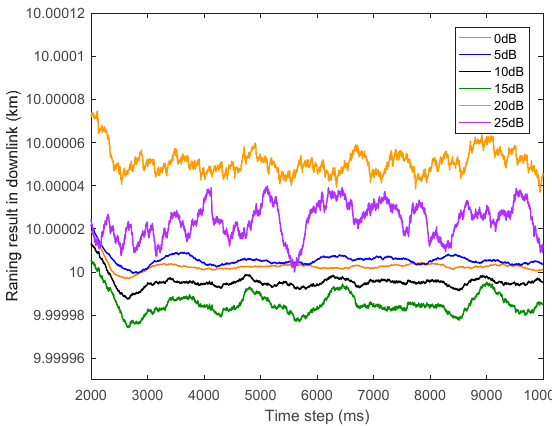
ff erent PWDFs with ( C / N